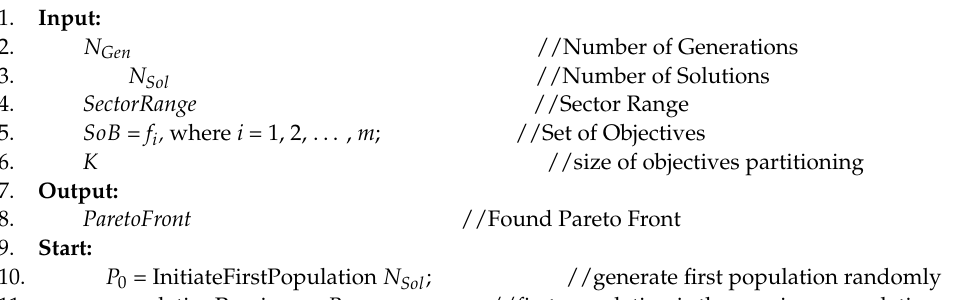
Algorithm 1 Pseudocode of the HAES